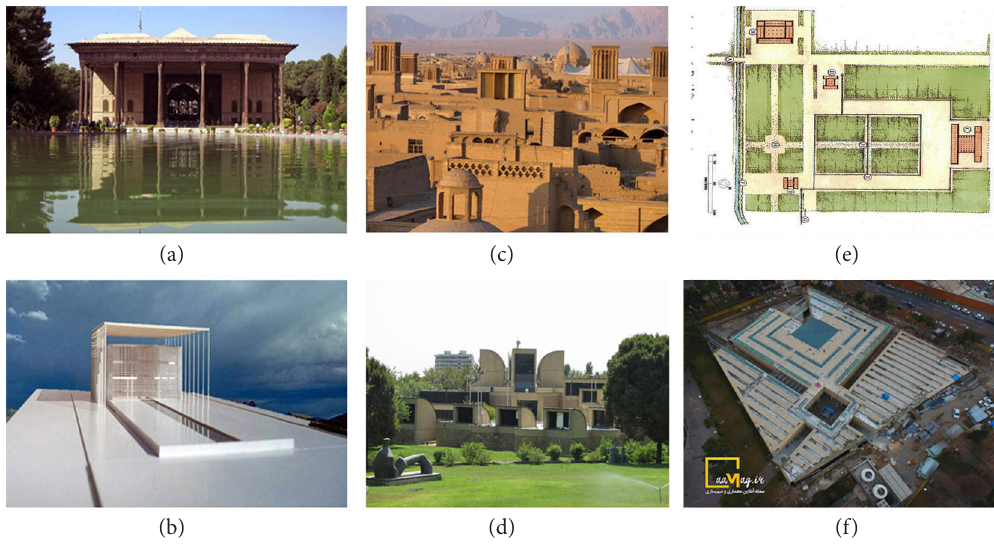
Figure 3. Examples of interpretation of concepts and patterns of traditional Architecture by the architects of the third generation: (a) Chehel Sotoon Palace from 1646 in Isfahan (Palmer, 2009); (b) Embassy of Iran in Zimbabwe by Hadi Mirmiran (Mirmiran, 2003); (c) Windcatchers in Kashan (Iranian Cultural Heritage, Handcrafts and Tourism Organzation [ICHHTO], 2014); (d) Museum of Contemporary Arts by Kamran Diba in Tehran, 1977 (Author, 2011); (e) Traditional Iranian Garden’s pattern (Bahmani & Karimi, 2015); (f) Library of Science and Technology University in Tehran by Farhad Ahmadi from 2010 (aaMag.ir,